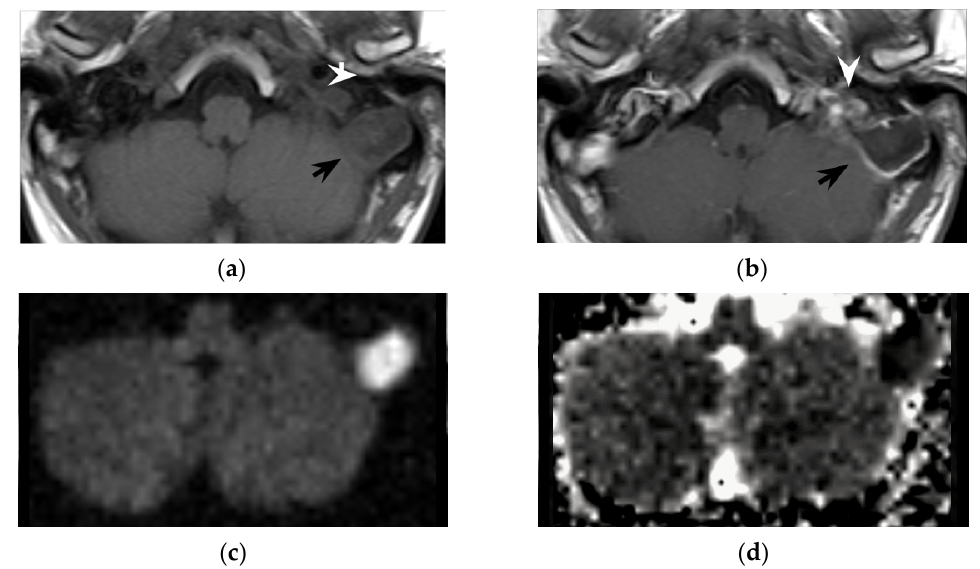
Figure 6. Thirty-seven-year-old man with chronic otitis media and history of ear surgery. MRI T1w ( a ) and contrast-enhanced T1w ( b ) sequences showing hypo-isointense material in the left mastoid (black arrows) spreading in the neck, in the posterior cervical space (white arrowheads). Note the mastoid mucosal enhancement, suggestive for mastoiditis, and the peripheral enhancement of the neck component ( b ). The material in the mastoid is hyperintense in diffusion-weighted imaging ( c ) and shows inhomogeneous apparent diffusion coefficient values ( d ), consistent with purulent col- lection and cholesteatoma. Bezold’s abscess and left mastoid cholesteatoma were confirmed at sur- gery.